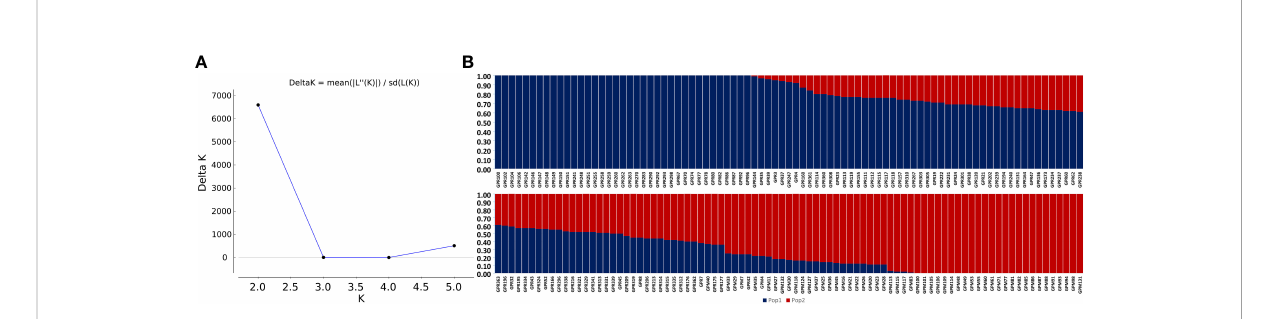
FIGURE 4 Linkage disequilibrium (LD) decay plot of the association mapping panel, the average r 2 values (Rsq) plotted against the distance (Dist) in base pairs